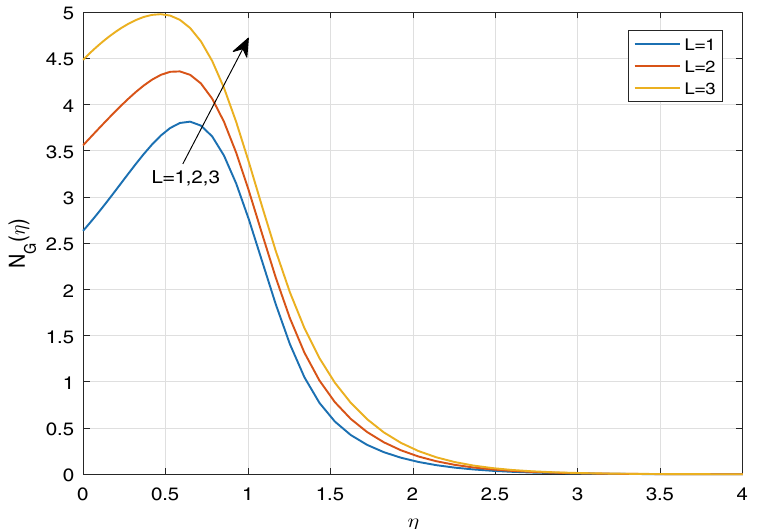
Figure 19. Sketch of N G against L .